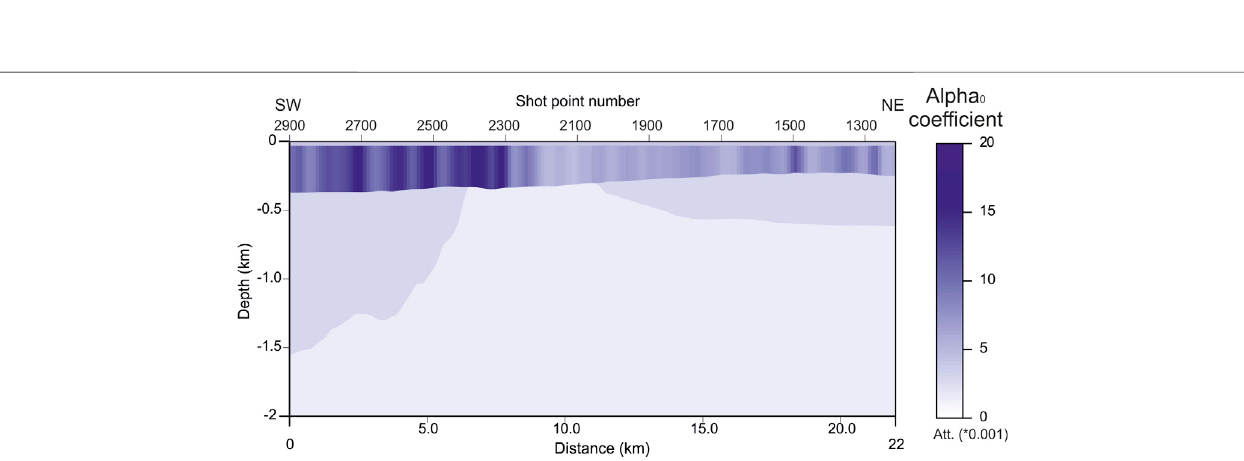
Frontiers in Earth Science |